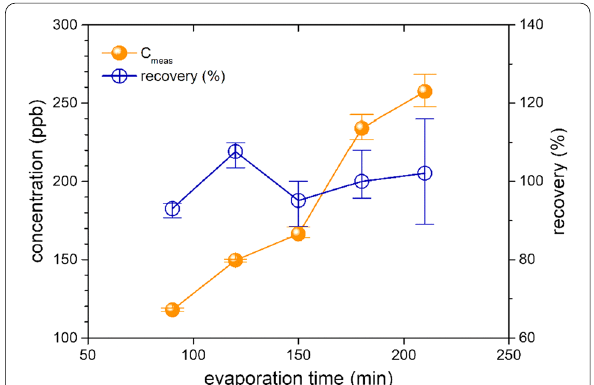
Fig. 4 C meas and recovery with different evaporation time of spiked 100 ppb Si in naphtha samples